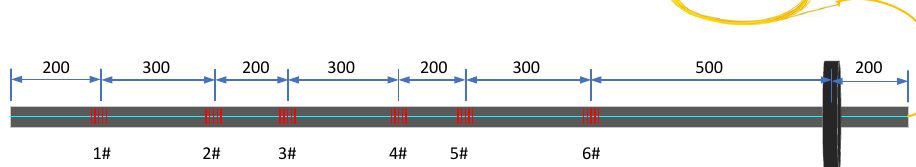
Figure 4. Schematic diagram of the fiber grating arrangement on the bolt body.